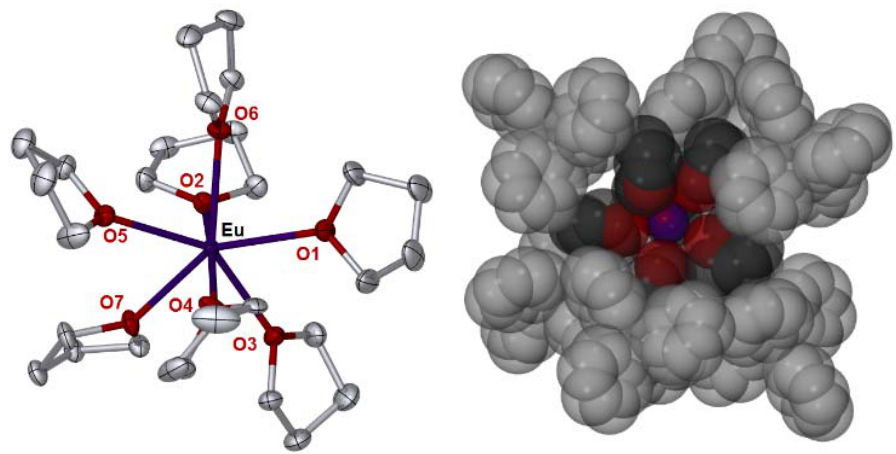
Figure 1. Left : Structure of the cation of 1 in the solid state drawn with ellipsoids at 50% probability